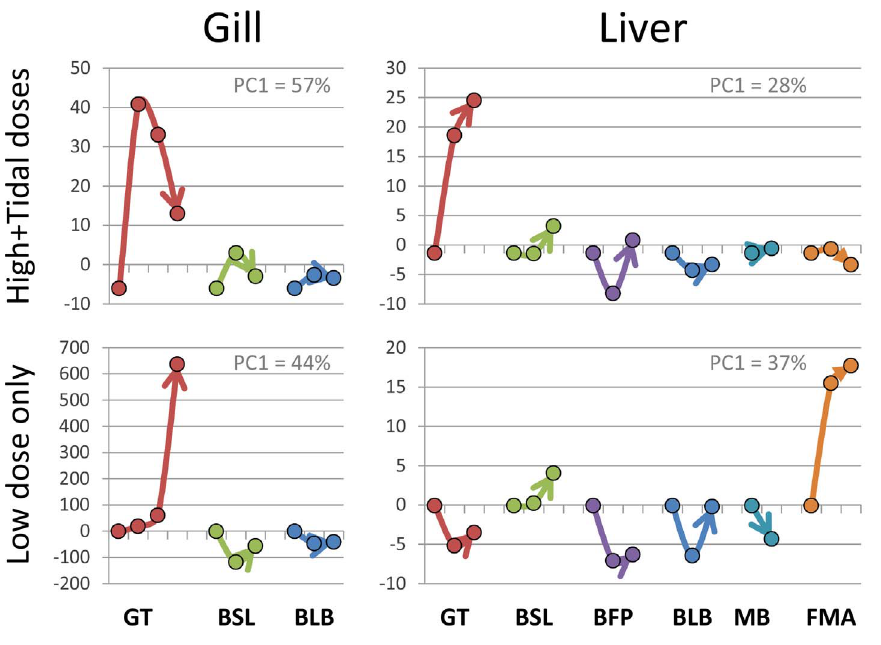
Figure 6. Trajectories for transcriptional change through time and across sites in the field study [20] for subsets of genes identified in the laboratory study reported here. Gill data are illustrated in left column panels, and liver data in right column panels. Principal component 1 (PC1) is plotted following PC analysis, and the proportion (%) of the transcriptional variation across sites and time accounted for by PC1 are indicated in brackets for each plot. Panels arranged by row represent different subsets of genes selected from the laboratory study, including the high- concentration responsive genes (row 1), and all the genes that were differentially expressed in the low concentration only (row 2). In the field study, liver responses were profiled across 6 sites at 3 time points, including Grand Terre Island (GT), Bay St. Louis (BSL), Bayou La Batre (BLB), Belle Fontaine Point (BFP), Mobile Bay (MB) and Fort Morgan Alabama (FMA) [20], before, during, and after (points at base, middle, and tip of arrows, respectively) peak oiling in 2010. The GT site was the only site directly oiled, and oil arrived between the first and second time-points. Gill responses were profiled at the oil-impacted GT site and two reference sites (BSL and BLB), at the same three time-points, plus an additional time-point at the GT site during summer 2011, one year after the third sampling